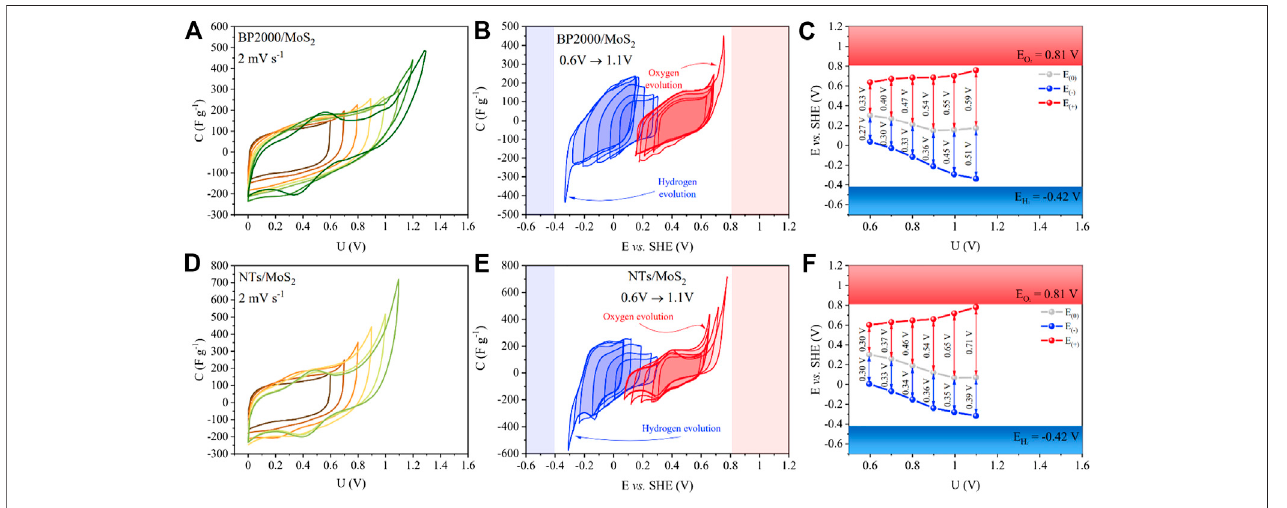
FIGURE9| ElectrochemicalcharacterizationofsymmetricECcellsbasedonMoS 2 composites.Cyclicvoltammogramsduringgradualvoltageextension — (A) and (D) . Individual cyclic voltammograms for (+) and ( − ) electrodes — (B) and (E) . Operational potentials for both electrodes at each voltage — (C) and (F)